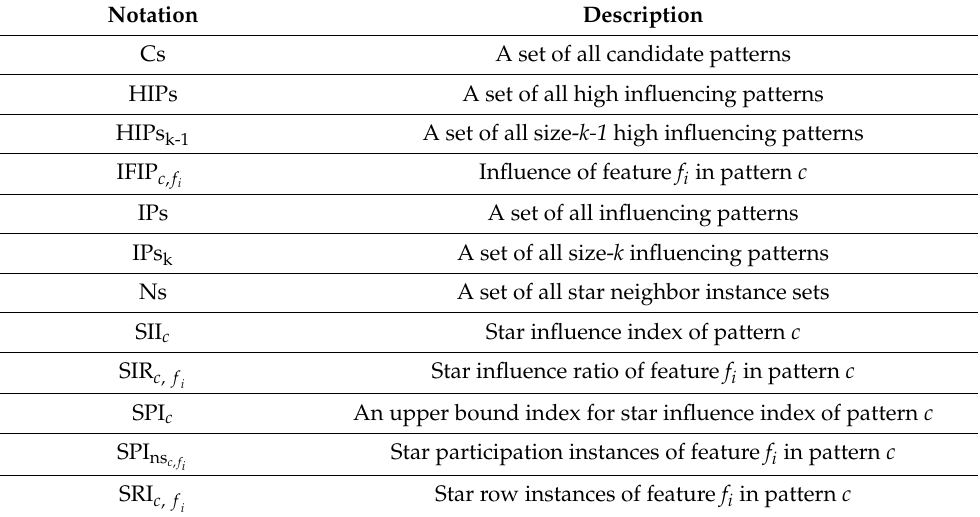
Table A1. Notation used in proposed Listing 1, Listing 3 and Listing 4 and called functions (in alphabetic